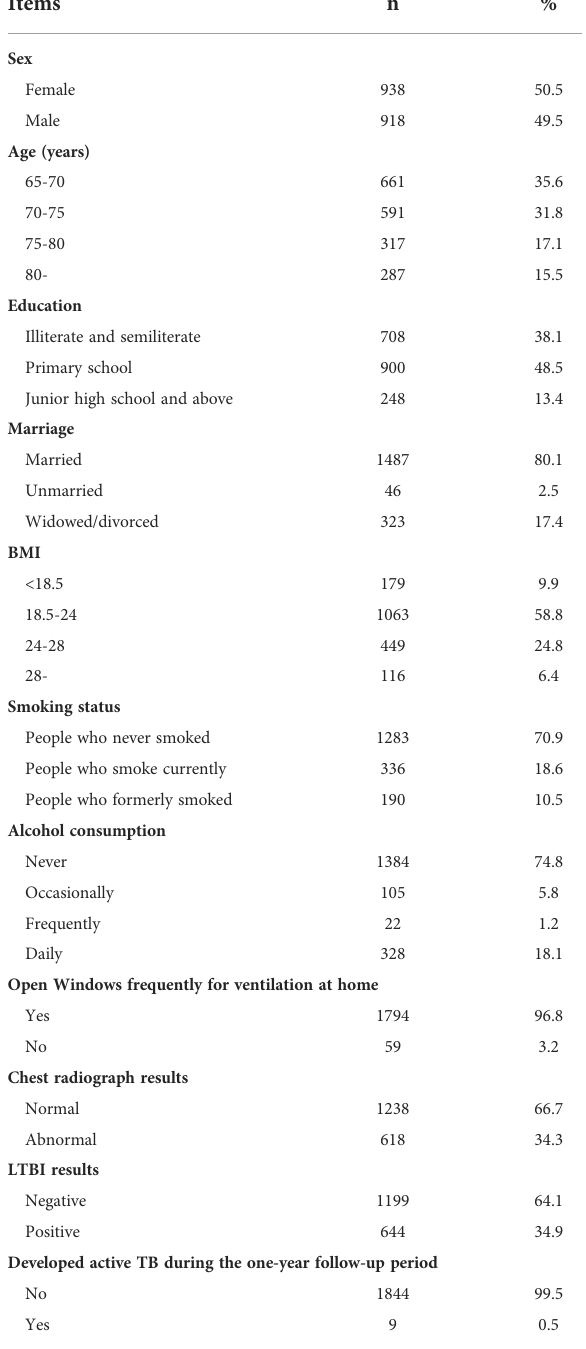
TABLE 1 Characteristics of study